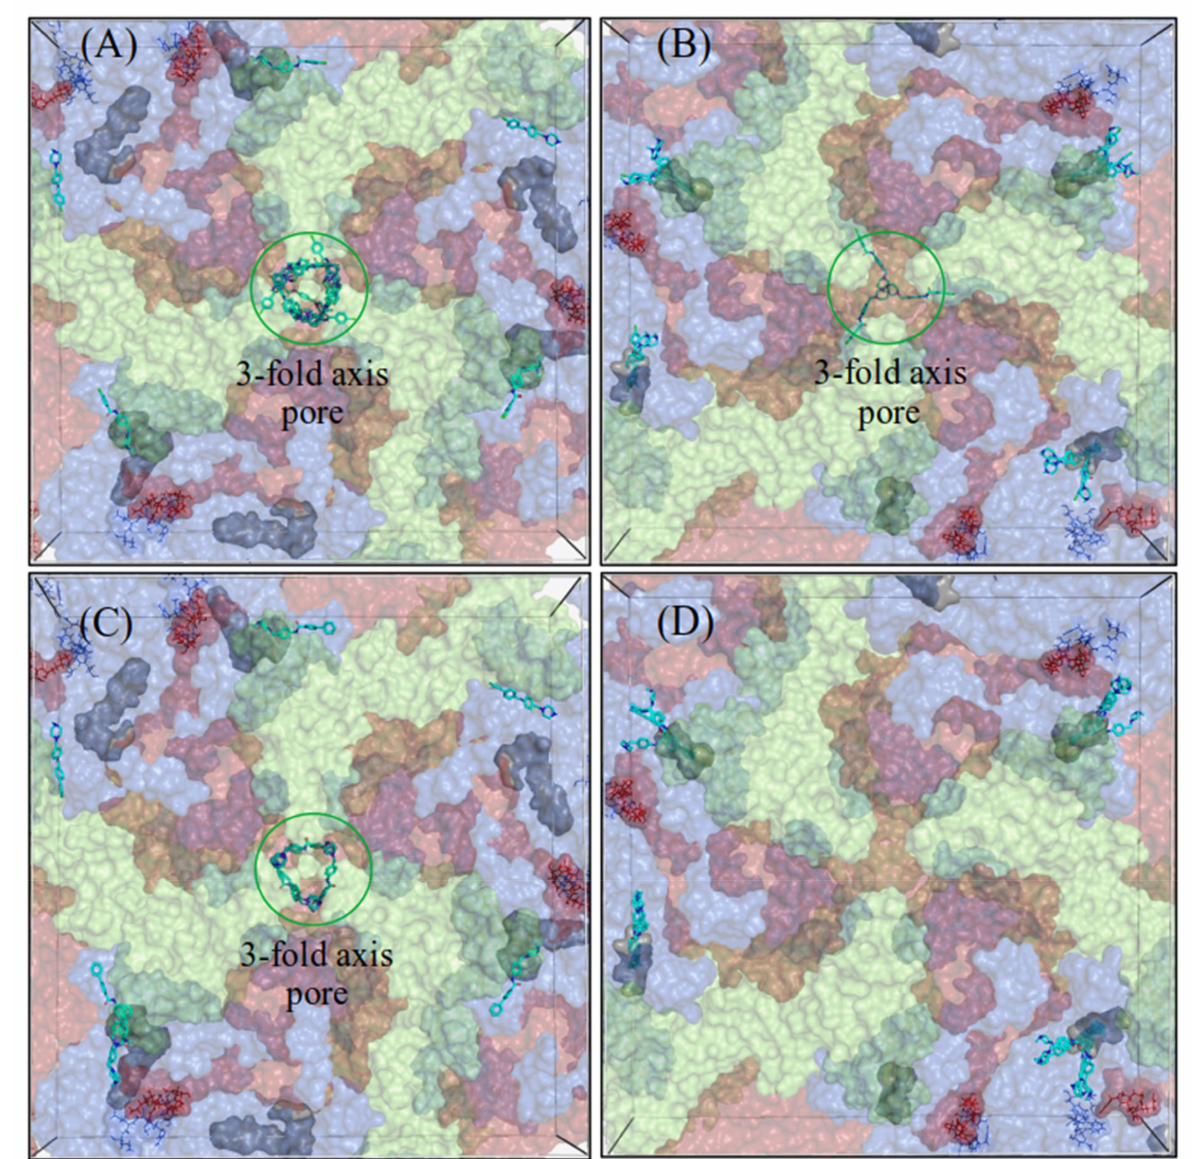
Figure 9. Docking grid boxes centered at the 3-fold axis of the virus capsid. ( A , C ) for CVA9 and ( B , D ) for CVB3. The docking poses of CL212 (upper panel) and CL213 (lower panel) are represented as cyan sticks. The hydrophobic pocket is represented as a grey surface and the Butcher-Neyts pocket as lines. The 3-fold axis pore is circled in green. The capsid proteins VP1–VP3 are colored blue, light green, and red, respectively. VP4 is not